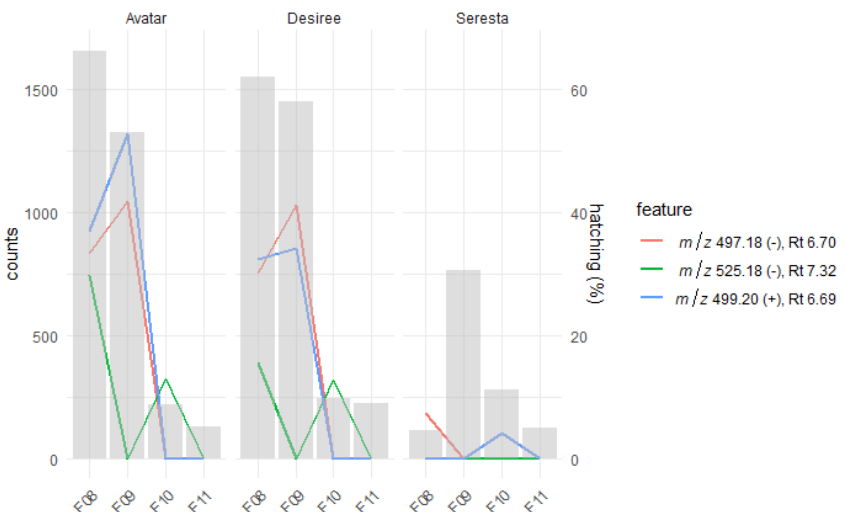
Figure 5. Count levels of individual features per fraction per genotype that were selected through Pearson’s correlation, RF feature selection, and their presence in the active fractions of root exudates. Line plots show the count levels of individual features, whereas the gray bars show the % hatching of PCN of the respective fraction induced. For solA, a retention time shift was observed between this experiment and the previous, whole root exudate analyses (Figure 2), 6.70 to 7.66 min.